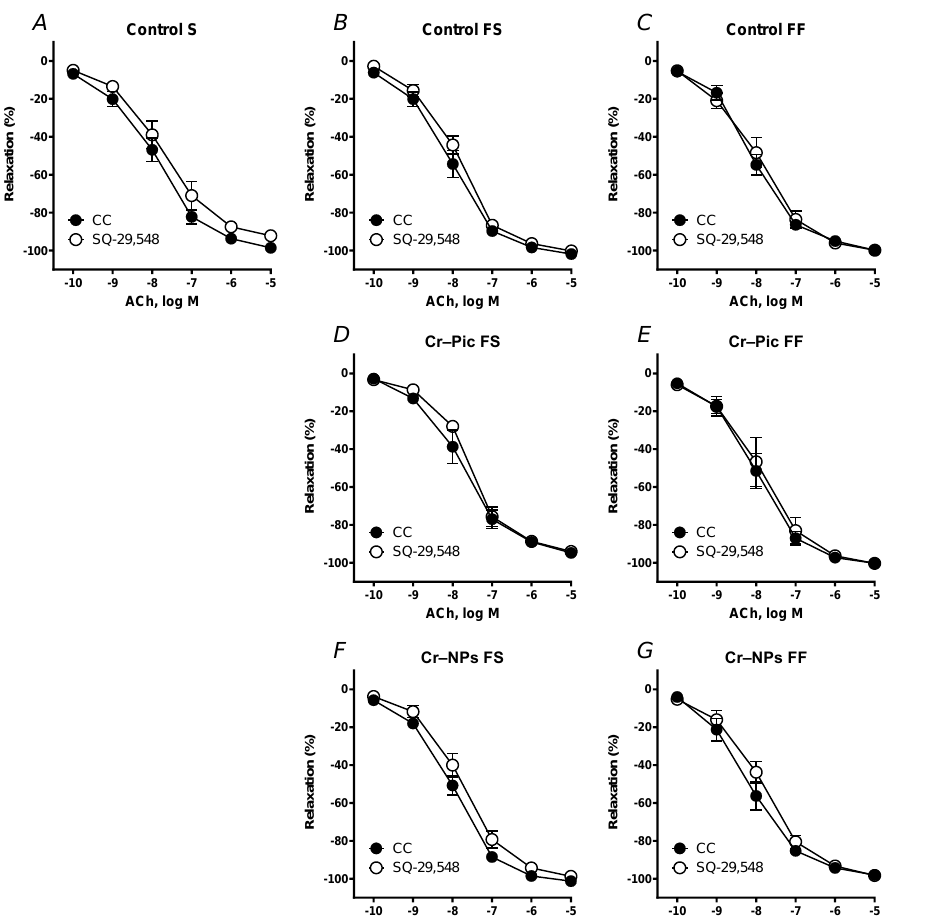
Figure 7. Effects of SQ-29,548 (1 µ M) on the concentration–response curves to acetylcholine (ACh) in aortic rings from the following groups of rats: control S ( A ), control FS ( B ), control FF ( C ), Cr–Pic